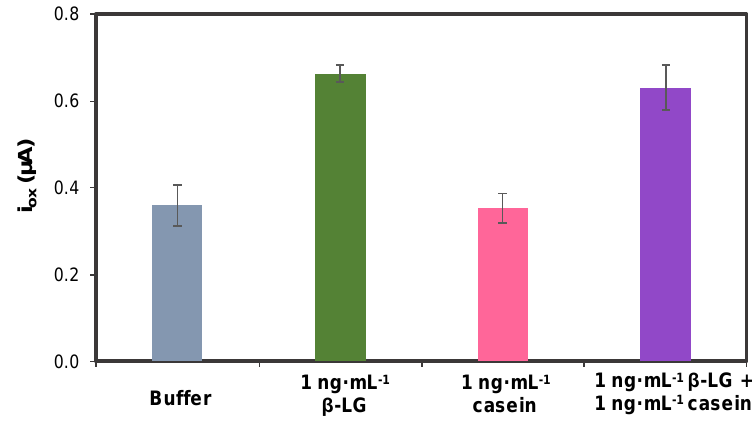
Figure 7. Study of the possible interference caused by casein. Experimental conditions: [Apt-MB] = 1 µM, Incubation time: 45 min, oxidation DPV recorded between – 0.60 V and +0.15 V, using the following conditions: modulation time: 0.02 s; interval time: 0.5 s; step potential 0.005 V; modulation amplitude 0.10 V. Solutions made in 0.1 M PBS, 150 mM NaCl pH = 7.4. Data are given as average ± SD (n = 3).